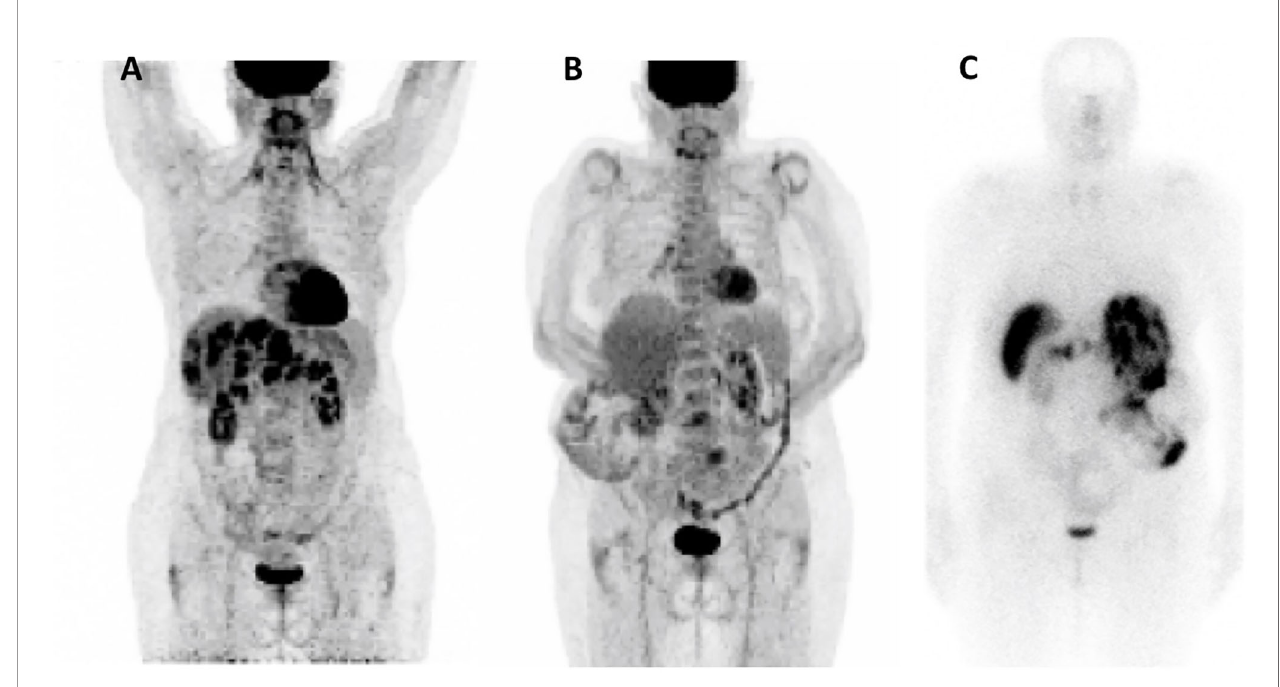
FIGURE 1 | Nuclear Imaging. (A) 18 F-FDG-PET/CT Oct 2018; (B) 18 F-FDG-PET/CT Dec 2020; (C) Octreoscan Dec